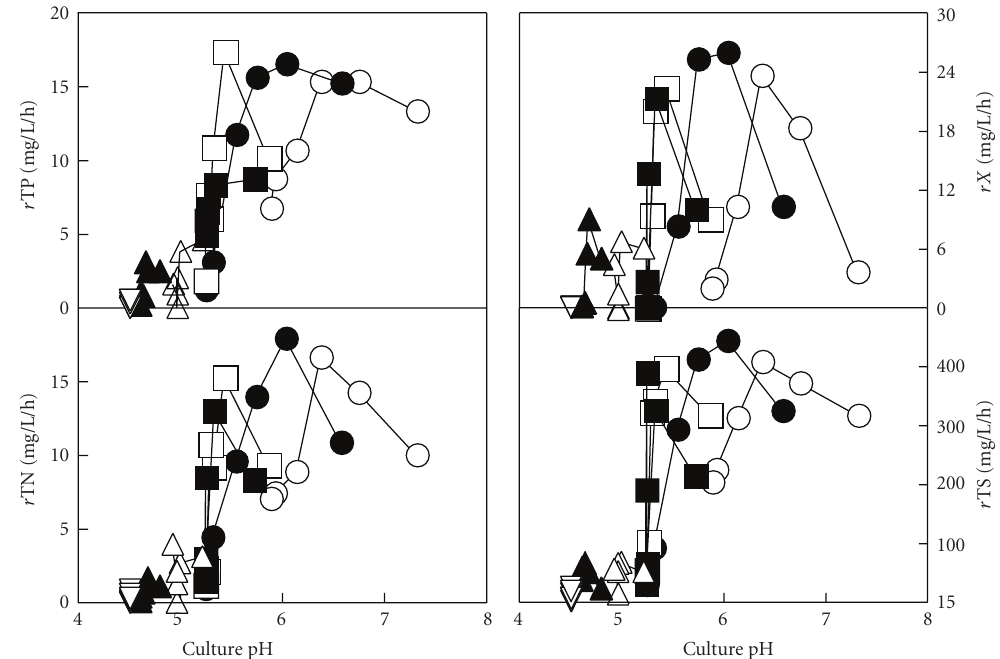
Figure 2: Changes in the absolute mean rates of growth ( rX ) and nutrient consumption (total phosphorous ( r TP), total nitrogen ( r TN), total sugars ( r TS)) with respect to the culture pH in the batch cultures of Ent. faecium CECT 410 on DW media adjusted to initial pH values of 7.5 ( (cid:3) ), pH 7.0 ( • ), pH 6.5 ( (cid:2) ), pH 6.0 ( (cid:3) ), pH 5.5 ( Δ ), pH 5.0 ( (cid:4) ), and 4.5 ( ∇